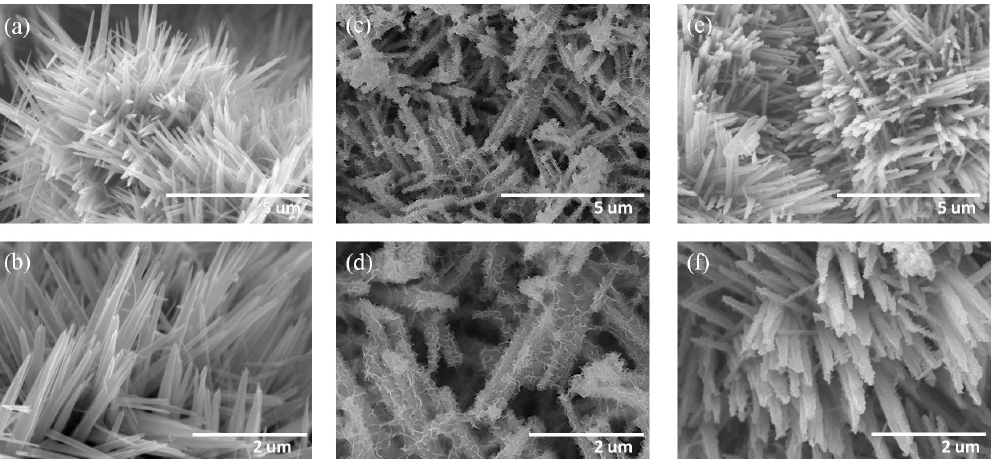
Figure 1. ( a , b ) Low- and high-magnification SEM images of TiO 2 nanostructures. ( c , d ) Low- and high-magnification SEM images of TiO 2 –NiO composites formed at 350 ◦ C. ( e , f ) Low- and high-magnification SEM images of TiO 2 –NiO composites formed at 500 ◦ C.